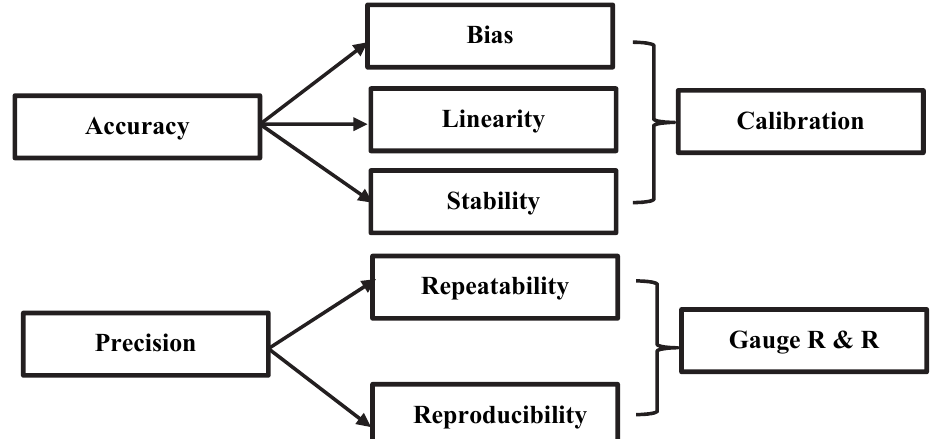
Fig. 1. Types of variations (The British Standards Institution 2008, MSA/Issue 1.3/July